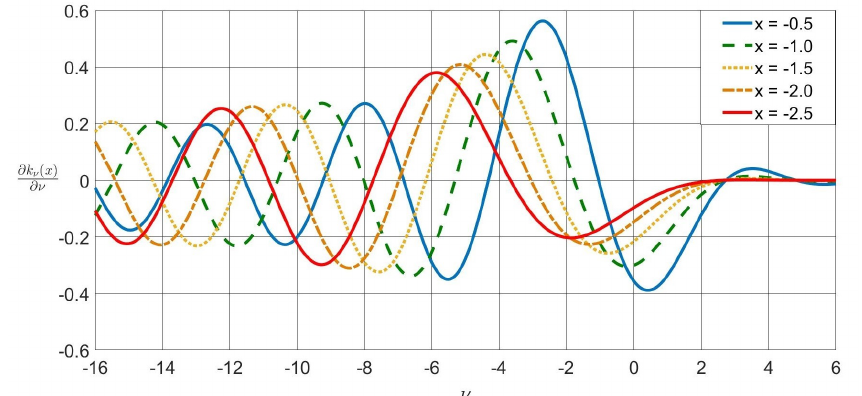
Figure 10. First derivatives of the Bateman functions with respect to the order at fixed negative values of argument x